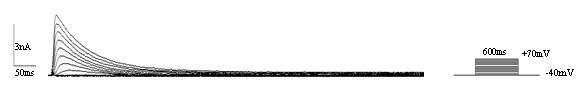
The representative current tracings of transient outward potassium currents at various test potentials: Currents were elicited by 600 ms depolarizing in the range of -40 mV to +70 mV pulses in +10 mV increments from -40 mV holding potential. The currents were enhanced with the increase of test potentials, activated rapidly and inactivated slowly.